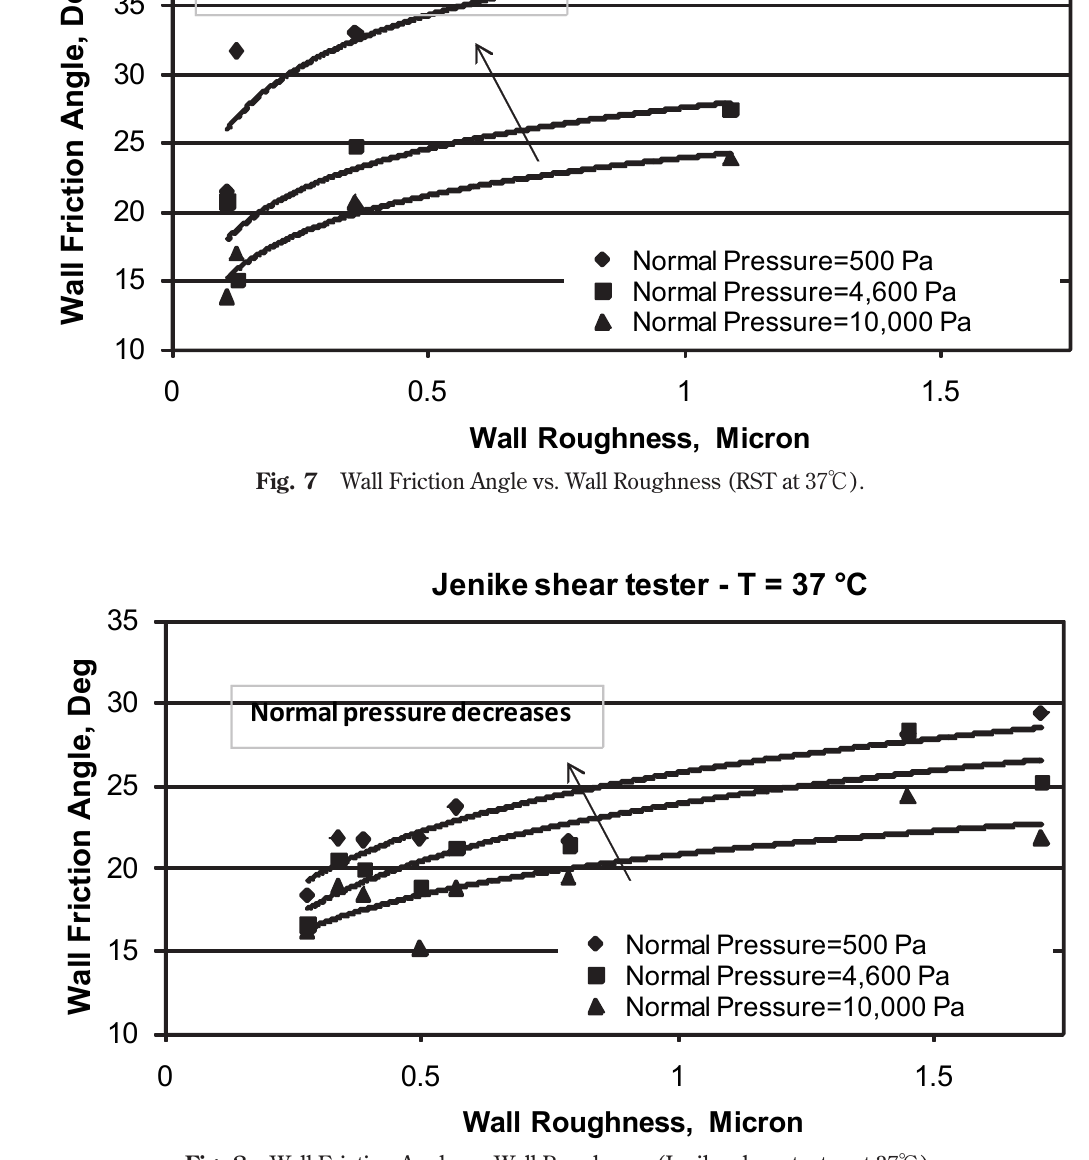
Fig. 8 Wall Friction Angle vs. Wall Roughness (Jenike shear tester at 37 ℃